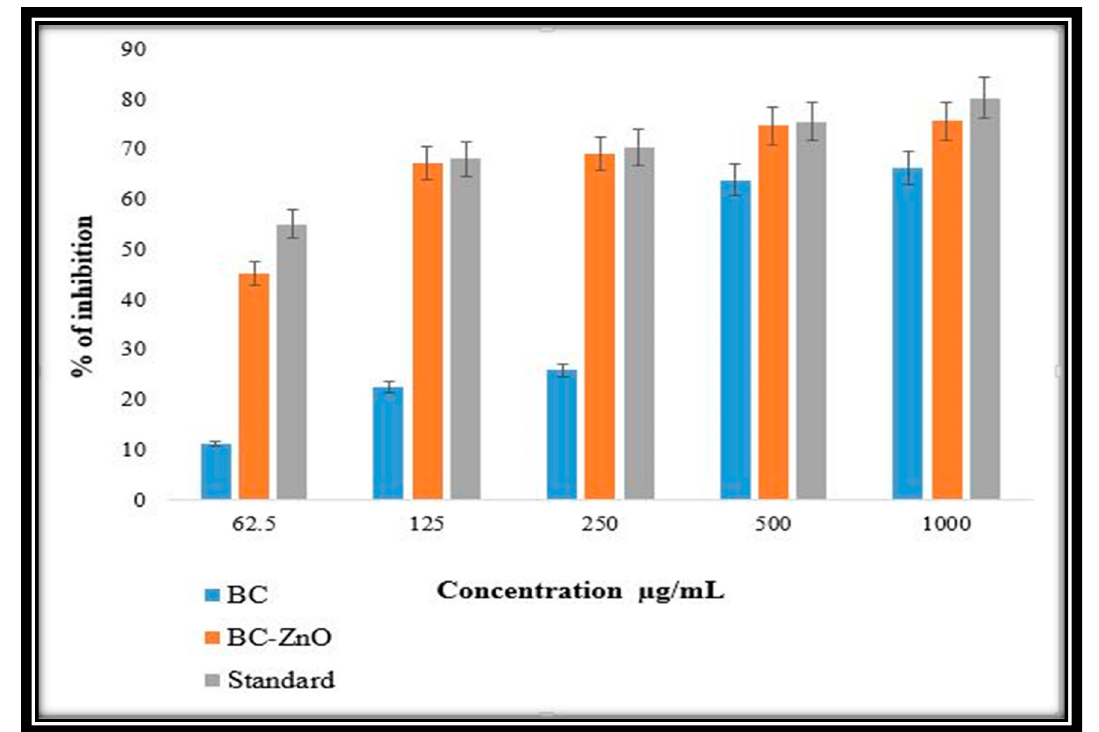
Figure 8. Anti-inflammatory activity of MB-ZnO nanocomposites.